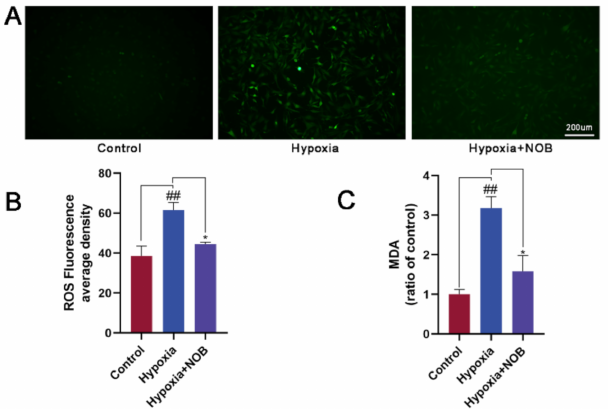
Figure 4. NOB treatment shows strong antioxidant effects on astrocytes activated by hypoxia for 24 h, and reduces the intracellular ROS and MDA levels. ( A ) The ROS fluorescent images of astrocytes in different groups. Scale bar, 200 µ m. ( B ) Quantitative analysis of ROS fluorescence intensities in different groups. ( C ) Statistical analysis of intracellular MDA levels in different groups. The values are shown as mean ± SD, n = 3, ## p < 0.01 vs. control, * p < 0.05 vs. hypoxia